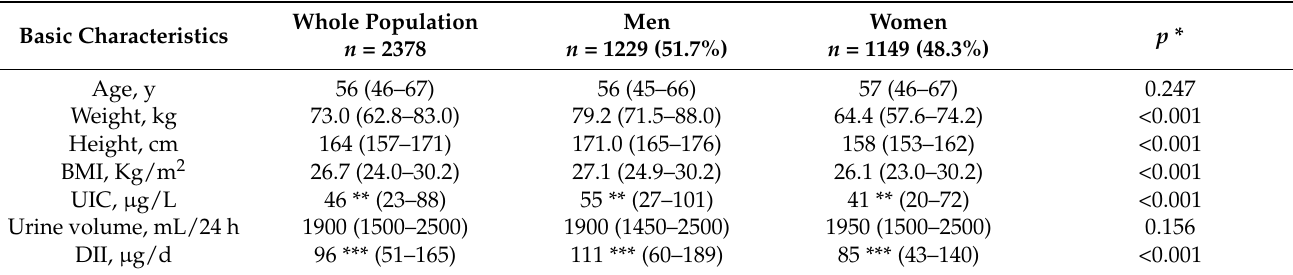
Table 1. Medians (IQR) of age, weight, height, BMI, urinary iodine concentration (UIC), 24 h urine volume, and daily iodine intake (DII), in the whole study population and by gender. Basic